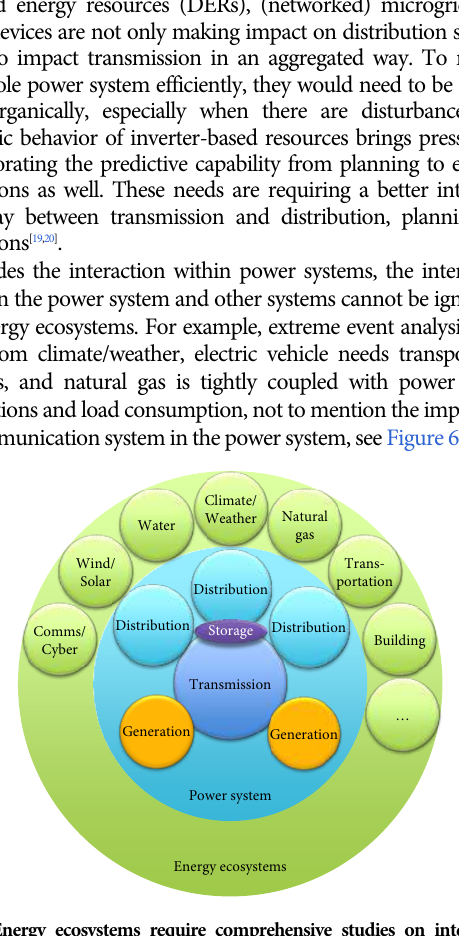
Fig. 6 Energy ecosystems require comprehensive studies on interactions among multiple energy